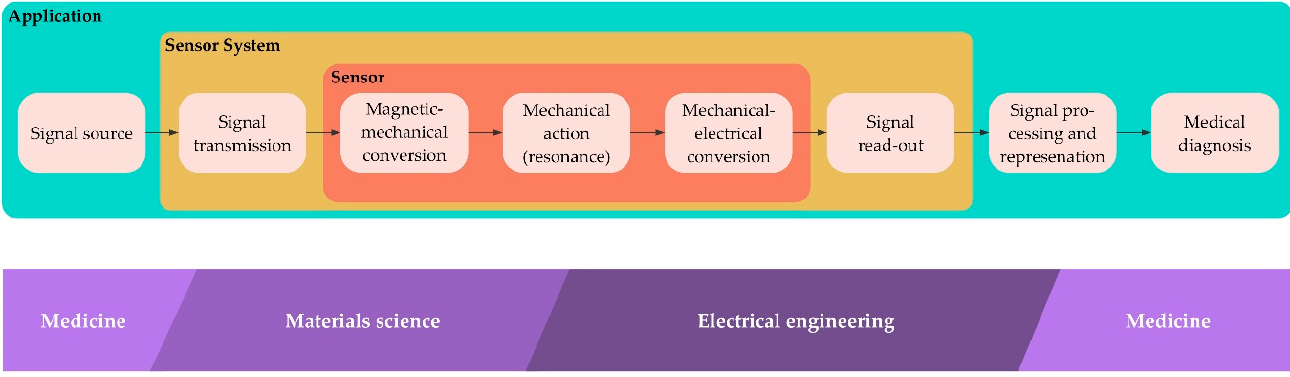
Figure 2. Biomagnetic sensing as a highly interdisciplinary application of magnetoelectric sensors (based on [20]).